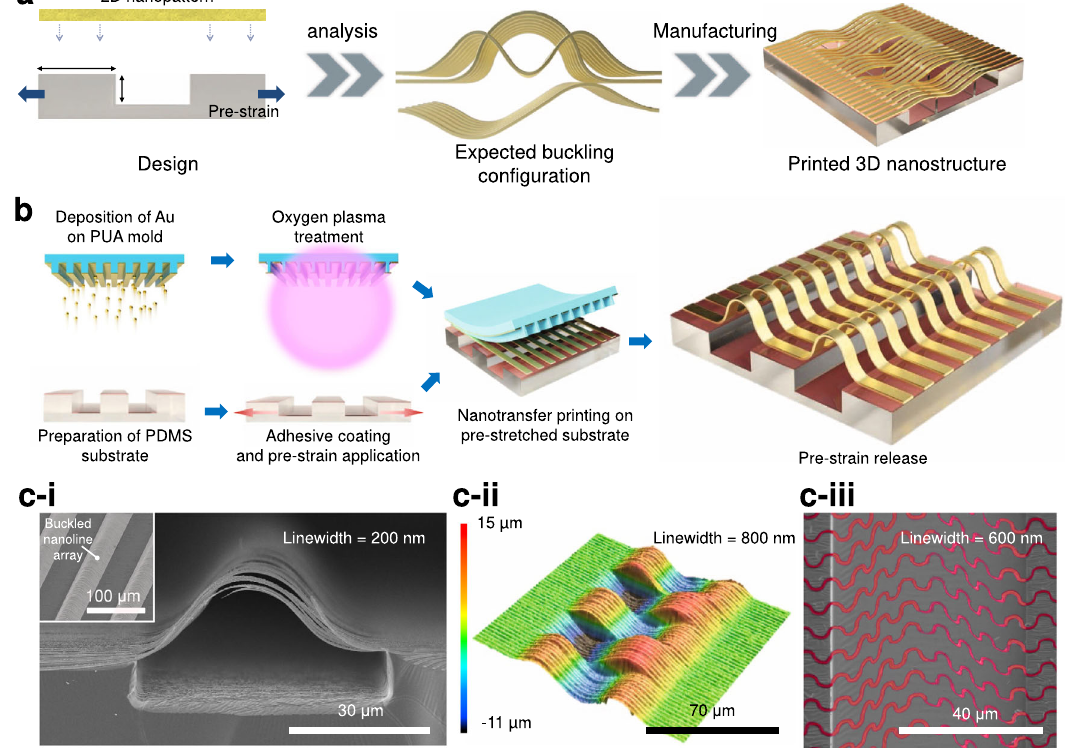
Fig. 1 | Concept and realization of con fi guration-designable nanoscale 3D